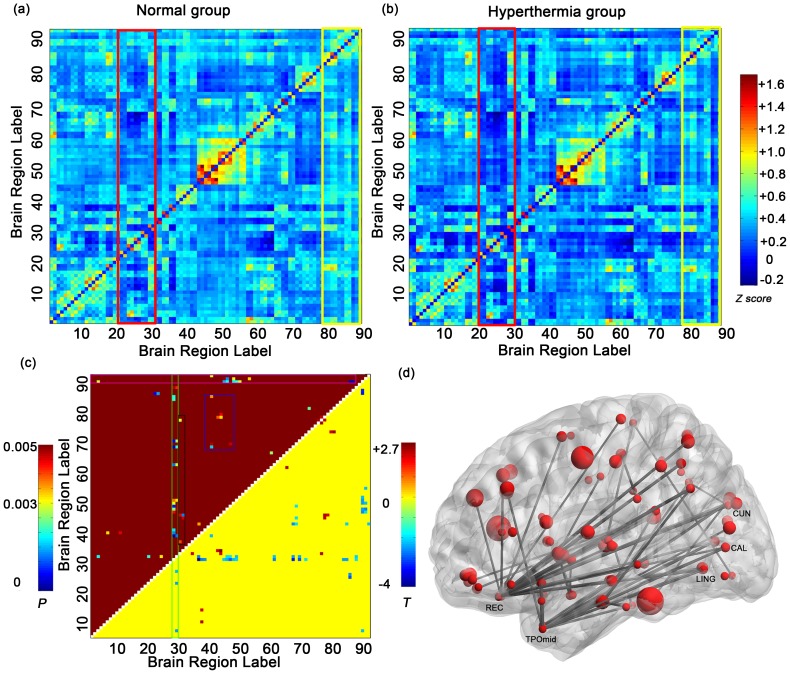
Results of functional connectivity analysis throughout the entire brain.(a–b) Mean zFC matrices of both groups throughout the entire brain divided into 90 regions by the AAL atlas. Visually different correlations between both groups mainly focused on the prefrontal regions (red rectangle) and temporal regions (yellow rectangle). (c–d) Significant correlations throughout the whole brain between both groups are depicted in the matrix figure (c) and brain network figure (d). The top-left triangle in Fig. 3 (c) exhibits the p value of the significant correlations and the bottom-right one exhibits the T value of the corresponding correlations. The rectangles in green, pink, blue and black represent significant altered correlations. Details can be seen in the Result part.